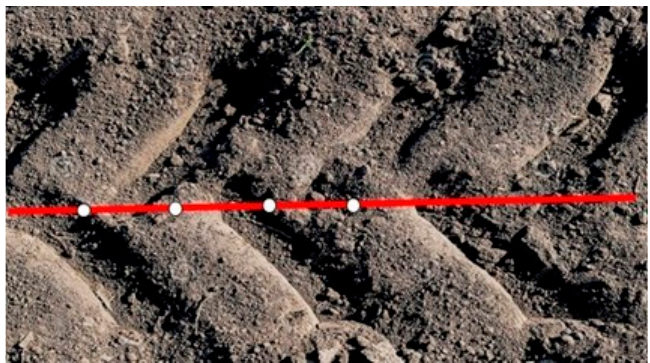
Figure 2. Measures of the PTL trace depth formed by the tractor front wheel.